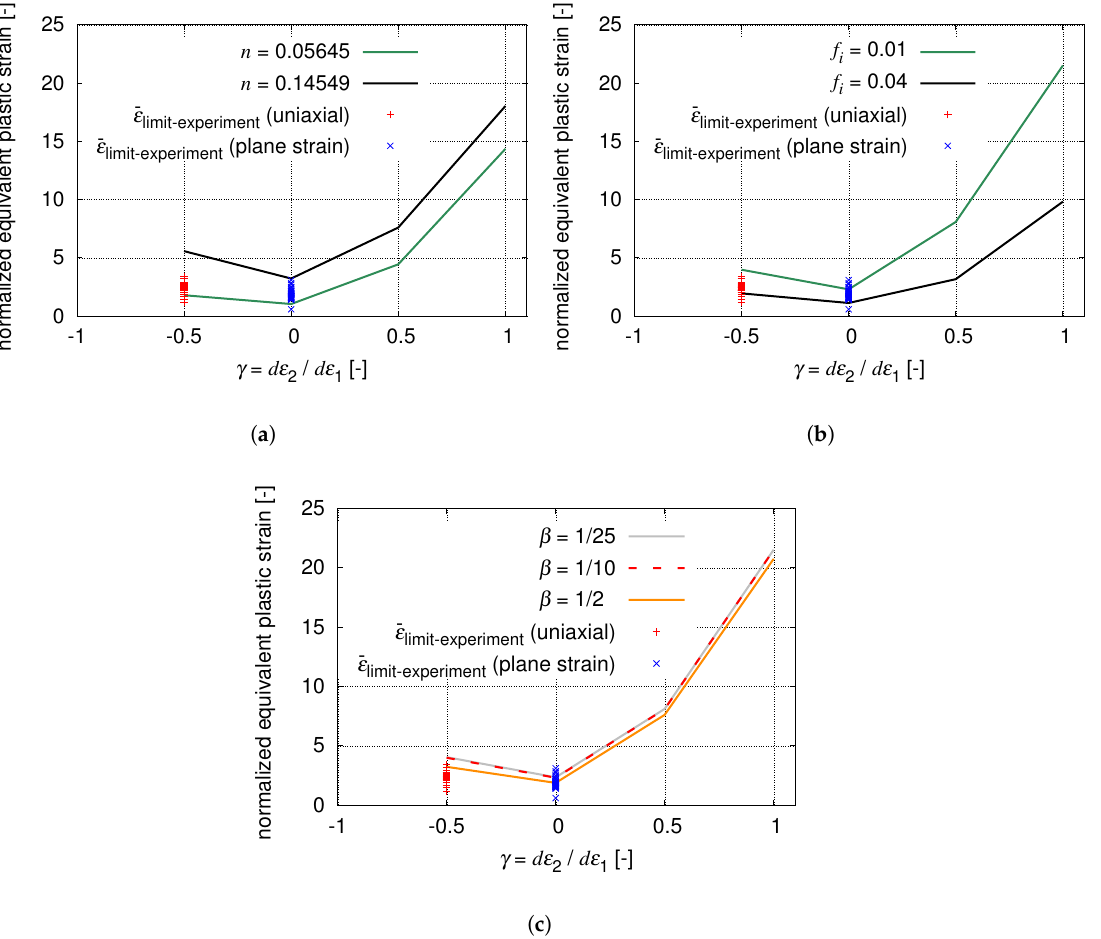
Figure 20. ( a ) Parameter study of strain hardening exponent n with constant f i = 0.02, ( b ) Parameter study of inhomogeneity parameter f i with constant n and ( c ) Influence of plastic instability indicator β with constant f i = 0.01 and n = 0.08579 (all strains are normalized with respect to the mean uniform